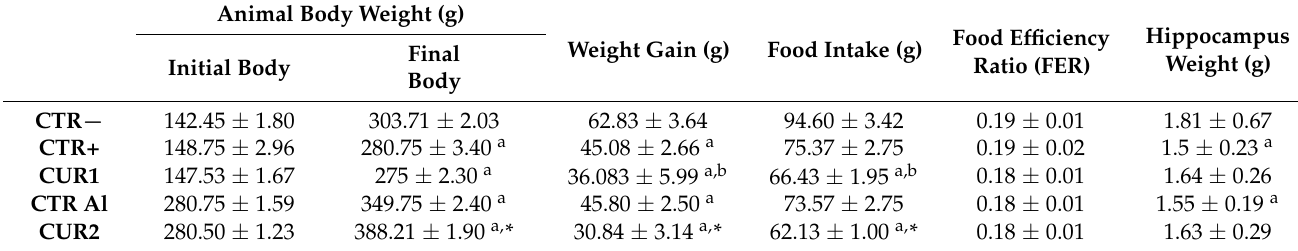
Table 1. Effect of co and post-treatment by curcumin on aluminum chloride–induced a change on organ, body and food parameters in rat.